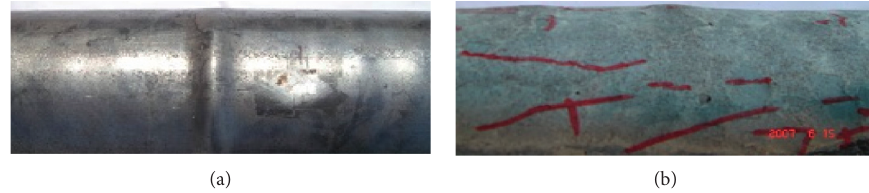
Figure 8: Internal and external damage of specimen failure. (a) Steel tube. (b)